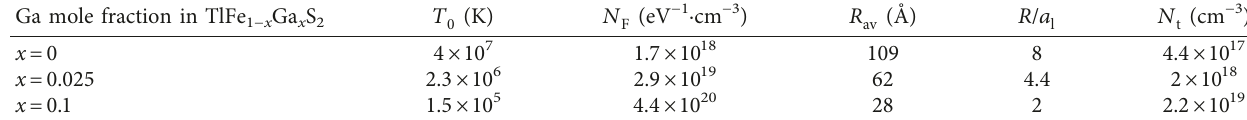
Ga S solid 1 − x x 2